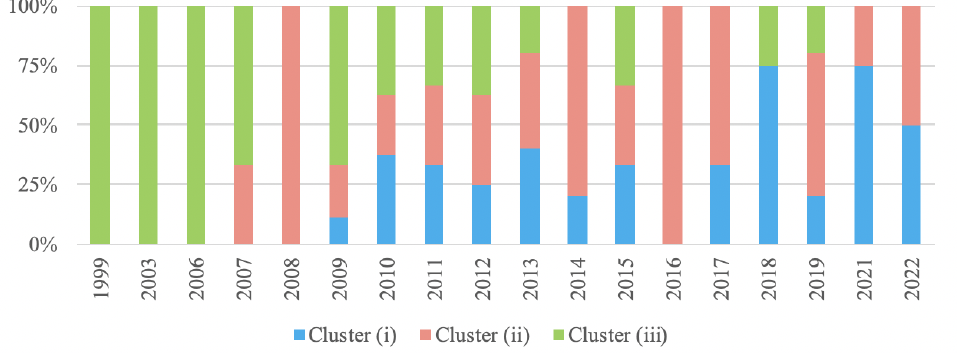
Figure 16. Evolution of the number of publications by